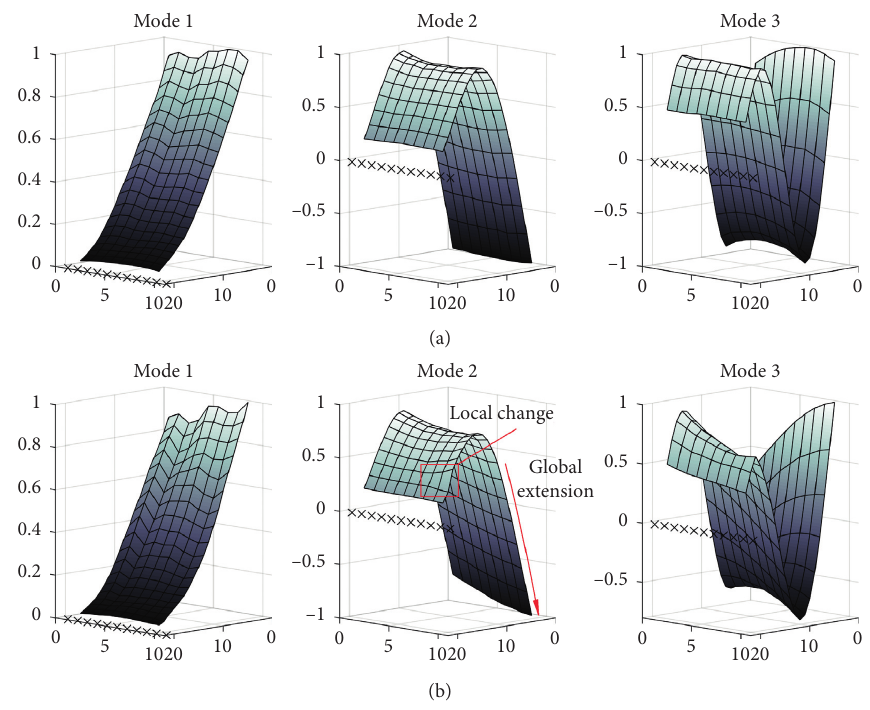
Figure 14: Comparison of the first three mode shapes for intact state (M#11) and full damage